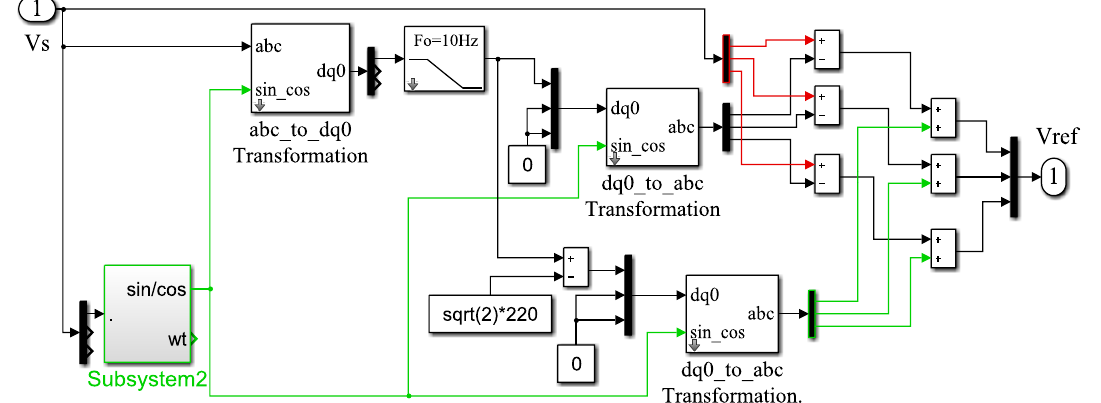
Figure 7. Proposed synchronous reference frame (SRF)-based compensation algorithm for the series filter (SF). Vref: voltage references.